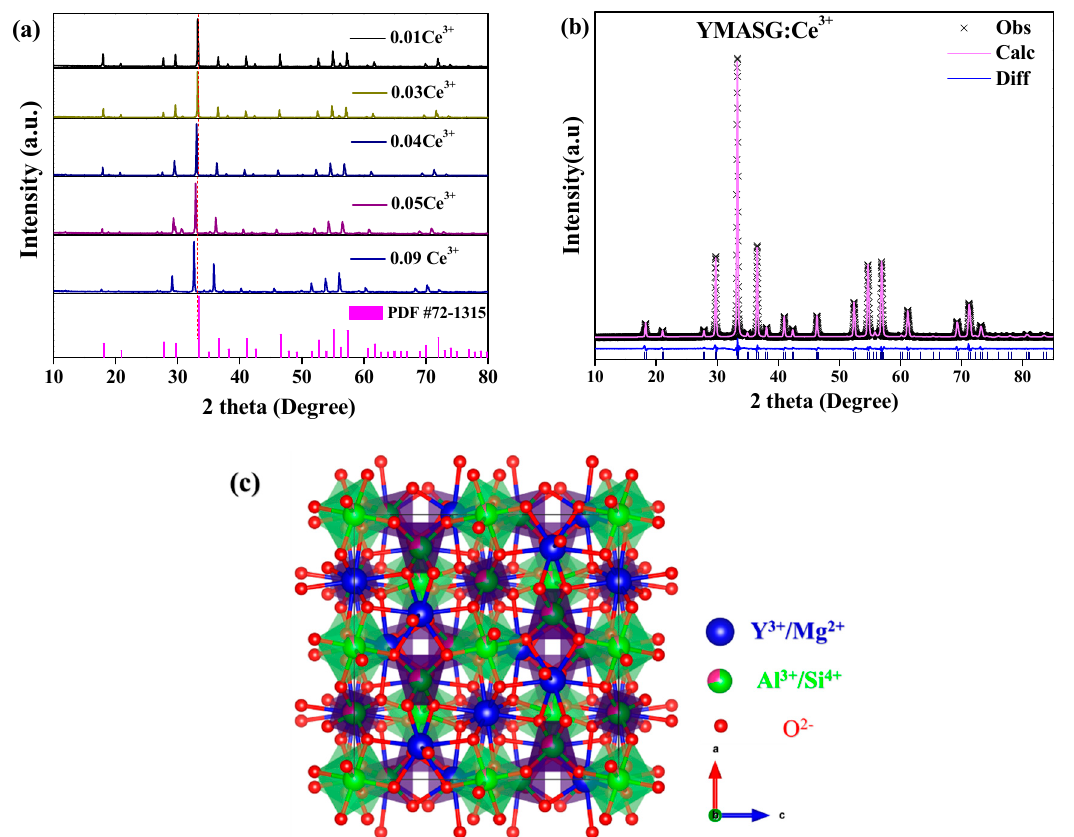
Figure 1. ( a ) The XRD patterns of YMASG:xCe 3+ (x = 0.01, 0.03, 0.04, 0.05, and 0.09) with the standard pattern of YAG (PDF #72–1315) as a reference. ( b ) The XRD refinement results of YMASG: 0.05Ce 3+ . ( c ) The unit crystal structure of the YMASG host.